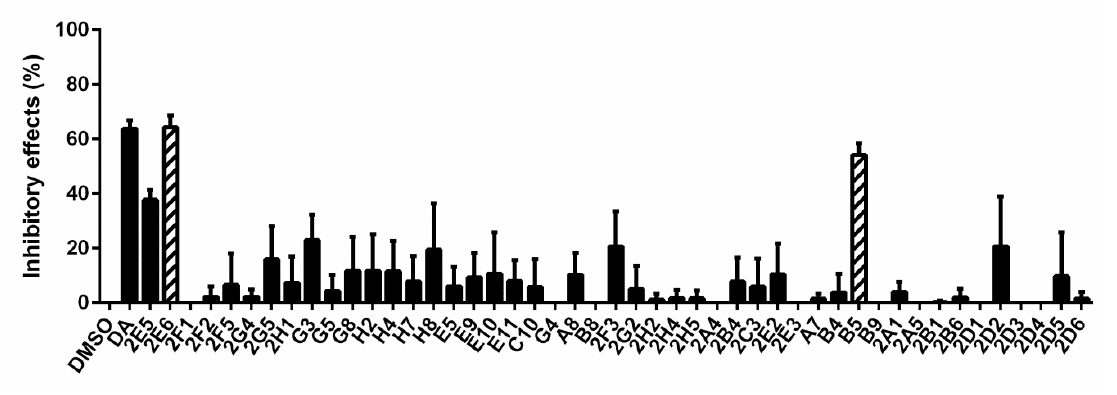
Figure 5. The inhibitory effects of 47 natural products on B. microti determined by flow cytometry. Two drugs (2E6 and B5) with significant differences from DMSO were finally selected as potential drugs against B. microti . The error bars indicate standard error of the means for each tested group.